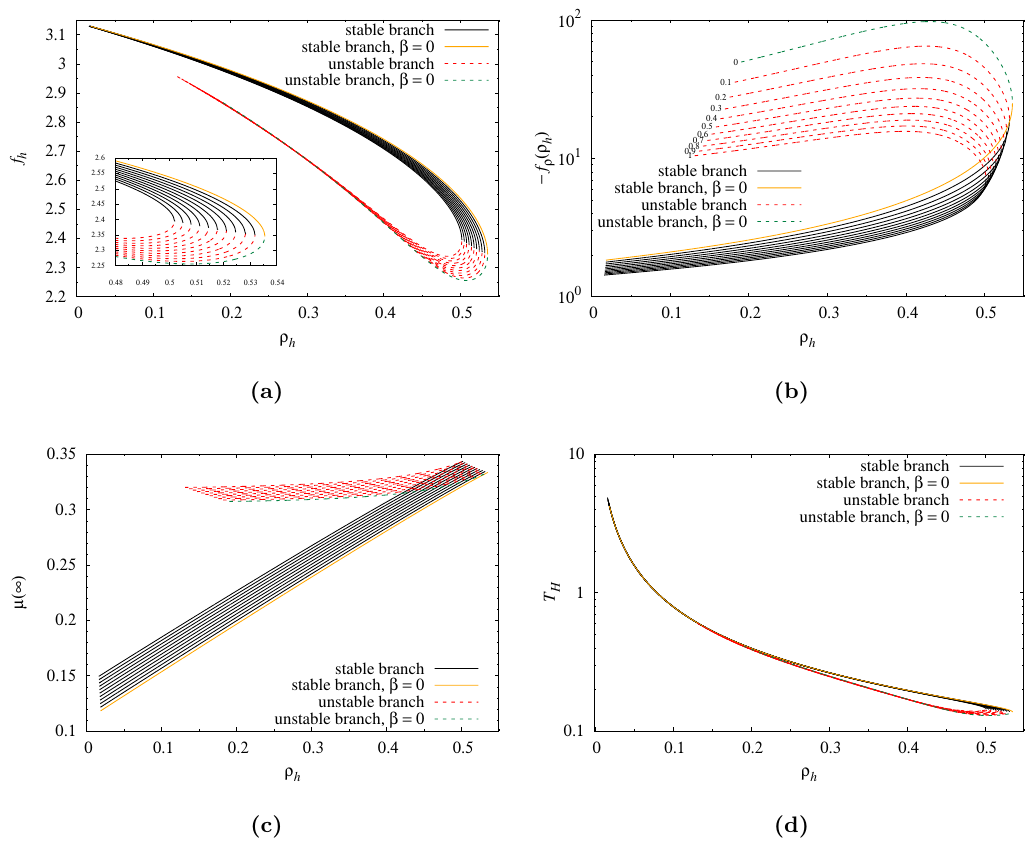
Figure 5 . Stable (black solid lines) and unstable (red dashed lines) branches of solutions in the 2+4+8 model with (cid:13) = 1: (a) the value of the pro(cid:12)le function at the horizon, f h ; (b) the derivative of the pro(cid:12)le function at the horizon, f (cid:26) ( (cid:26) h ); (c) the ADM mass, (cid:22) ( 1 ); (d) the Hawking temperature T H , all as functions of the size of the black hole, i.e. the horizon radius, (cid:26) h . The numbers in (b) indicate the di(cid:11)erent values of (cid:12) = 0 ; 0 : 1 ; 0 : 2 ; : : : ; 1. In (a) (cid:12) = 1 for the innermost branch (both stable and unstable), and decreases to (cid:12) = 0 for the outermost branch. In (c) the topmost branches (both stable and unstable) correspond to (cid:12) = 1 and the branches move downward as (cid:12) ! 0. The stable and unstable (cid:12) = 0 branches are shown in orange and dark green colors,